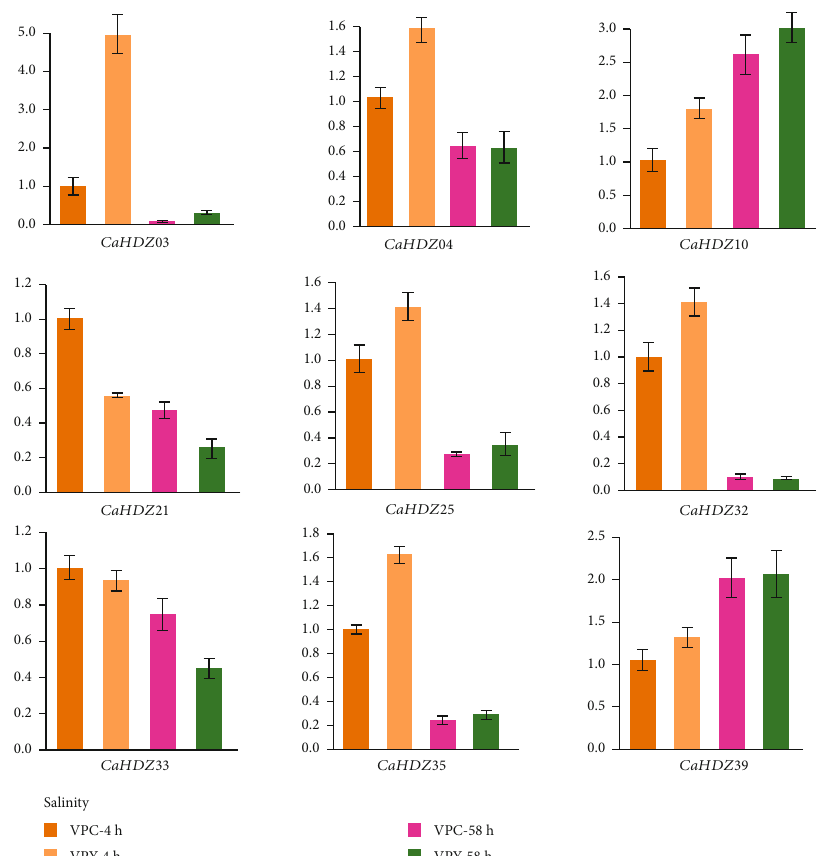
Figure 6: The heat map of the CaHD-ZIP genes under NaCl treatment (VPC represents CK, VPY represents NaCl stress). Expression patterns of 9 CaHDZ genes under salt stress. Salt stress (100mM NaCl) was carried out on pepper seedlings at the six-leaf stage. The relative expression level of CaHDZ gene was analyzed by qRT-PCR, using sesame VPC4h gene as the internal